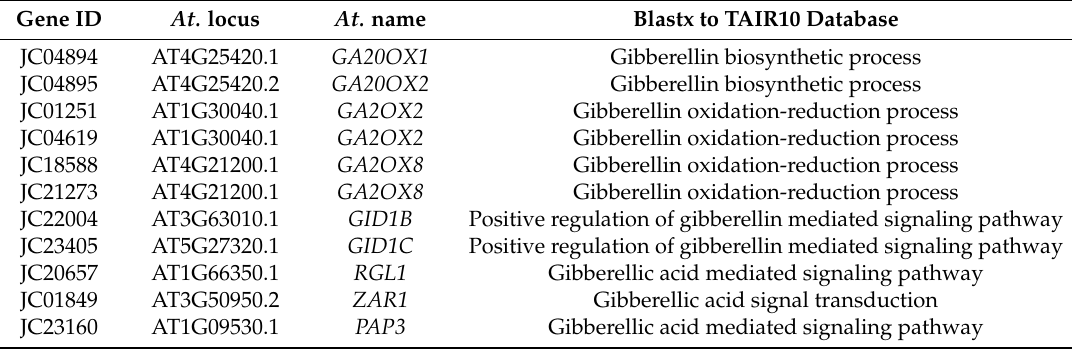
Table 2. The DEGs associated with GA biosynthetic and signaling pathways after GA 3